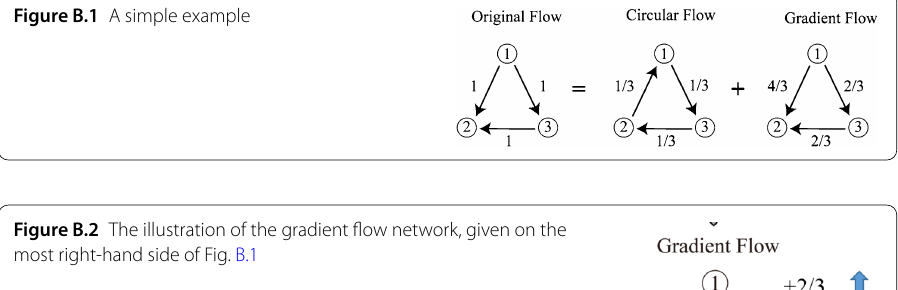
Figure B.2 The illustration of the gradient flow network, given on the most right-hand side of Fig.